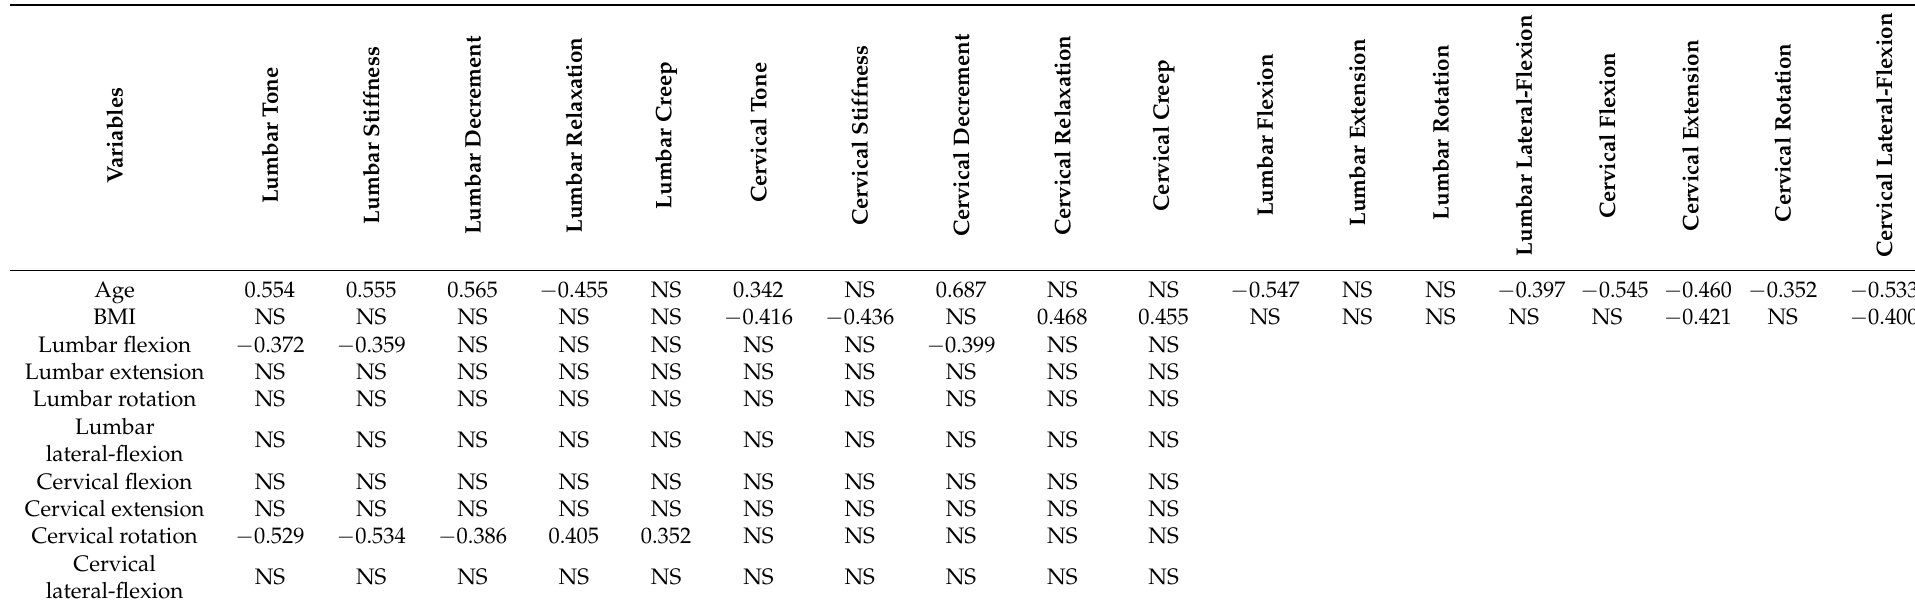
Table 3. Correlations between sociodemographic and clinical characteristics within the acute low back pain